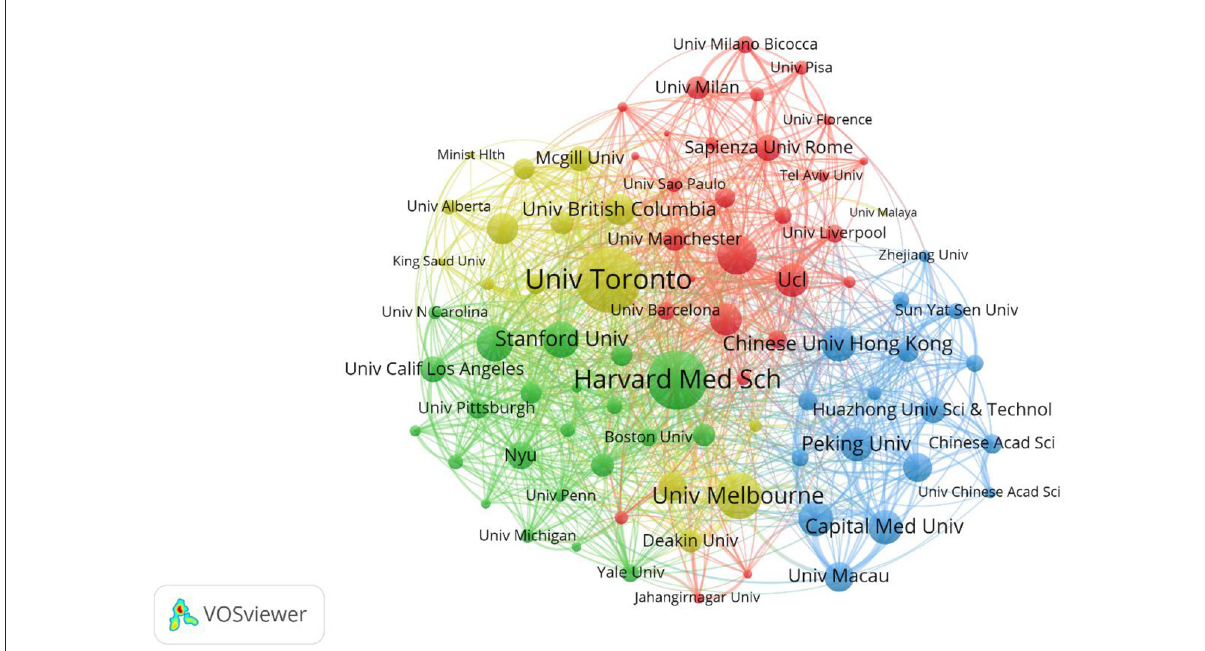
FIGURE4 Map of institution network. The nodes represent institutions. The lines represent cooperation relationships.